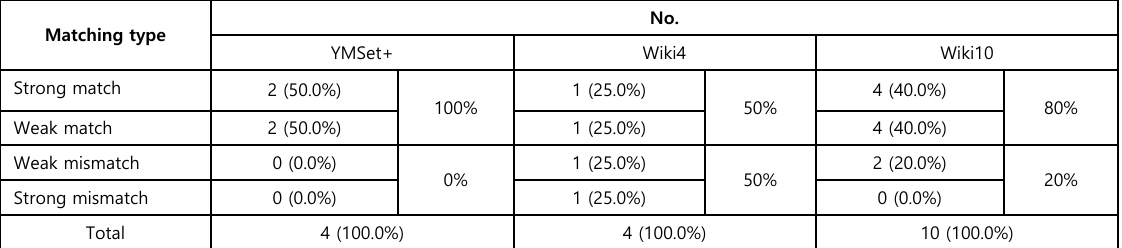
Figure 24. The matching results of recognition